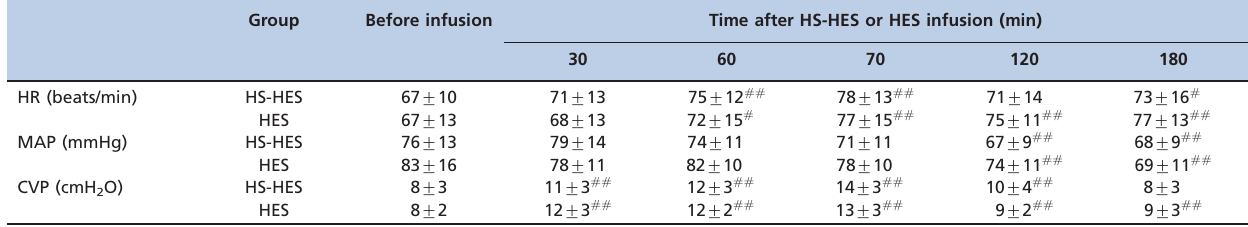
# p , 0.05 versus the measurement before infusion, ## p , 0.01 versus the measurement before infusion. The data are presented as the mean ¡ SD. HR: heart rate, MAP: mean arterial pressure, CVP: central venous pressure.